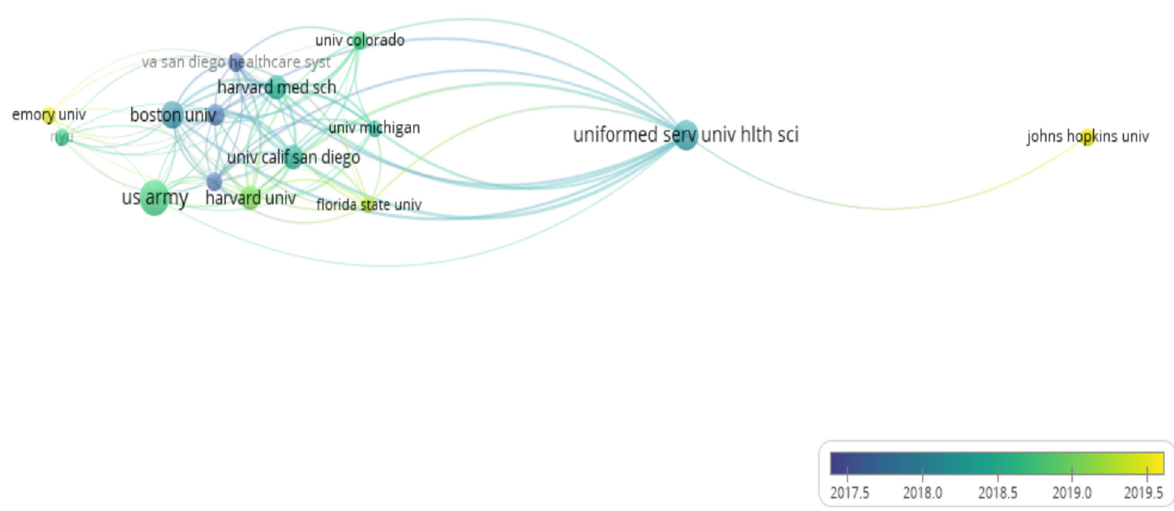
Figure 19. Network by citation.